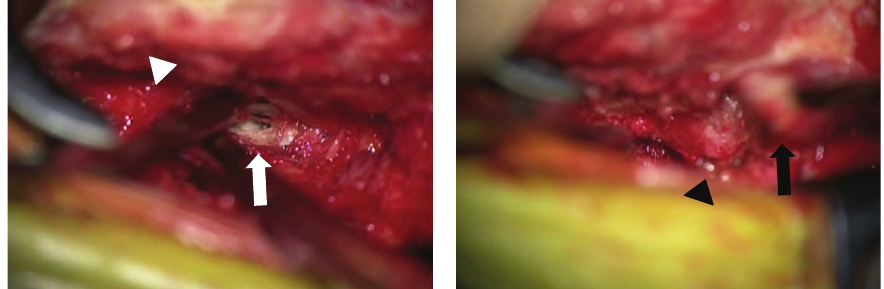
Figure 4: Intraoperative view showing the left L3 nerve root (white arrowhead), left L4 nerve root (black arrowhead), disc hernia (white arrow), and removed hernia (black